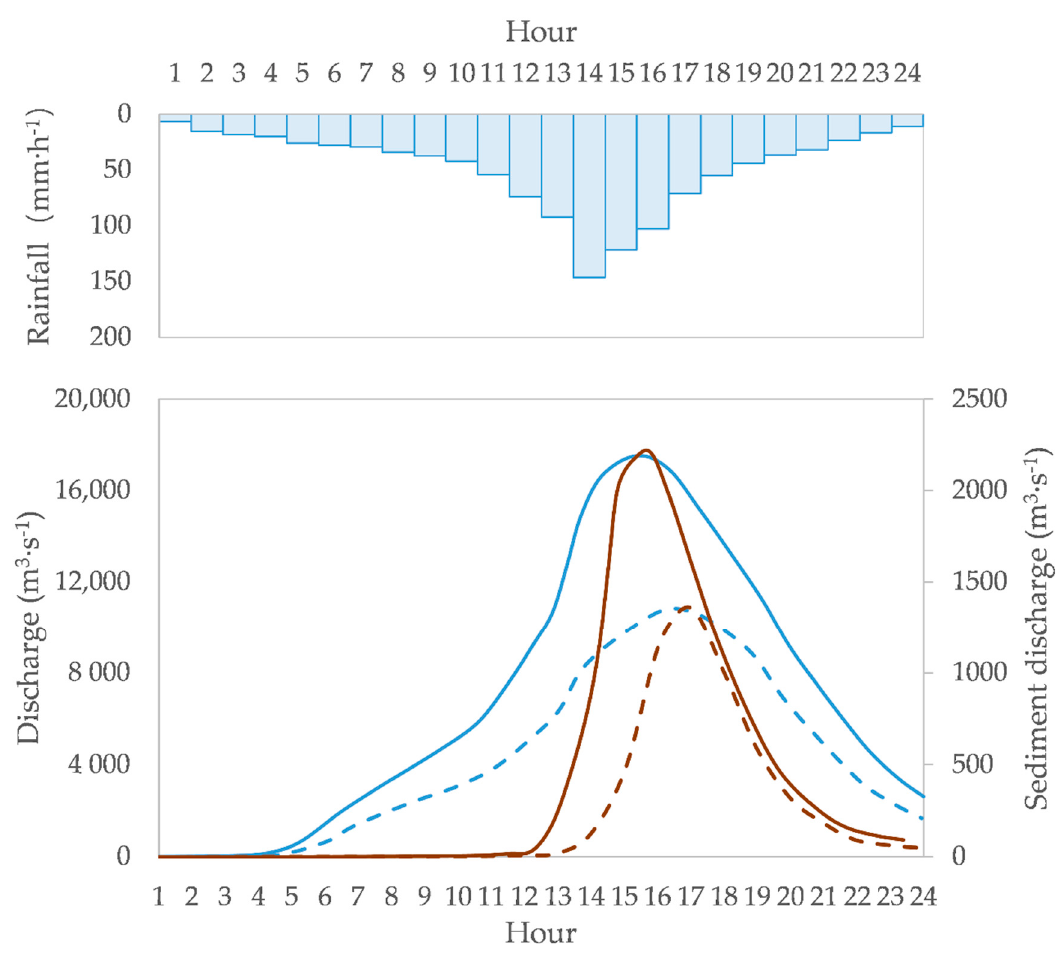
Figure 9. Result for the return periods of 200 years in the Shihmen Reservoir Watershed. The blue solid and dot lines represent the flow discharge at the downstream (Lofu Bridge) and upstream (Yufeng Station), and the brown solid and dot lines denote the sediment discharge at the downstream (Lofu Bridge) and upstream (Yufeng Station).